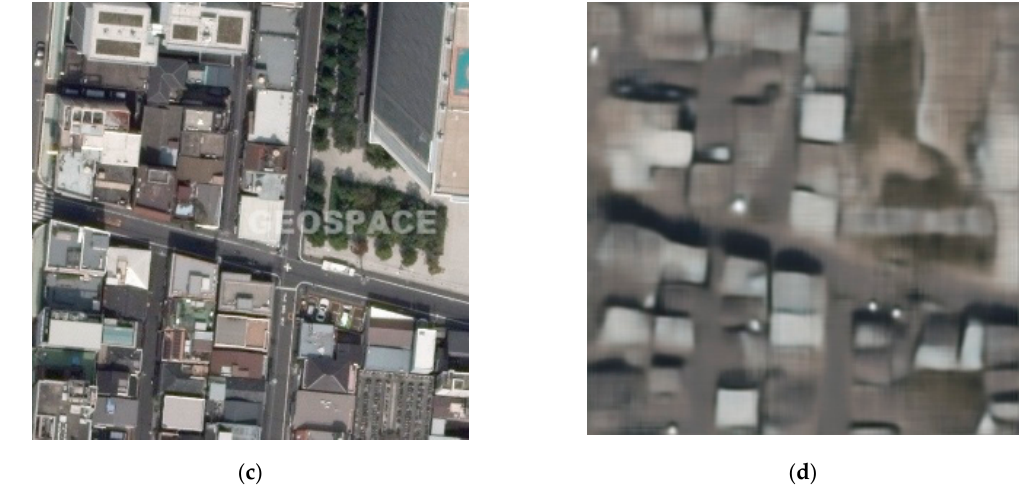
Figure 12. Reconstructed image samples. ( a ) An original source domain image, ( b ) a reconstructed source domain image, ( c ) an original target domain image, ( d ) a reconstructed target domain image.